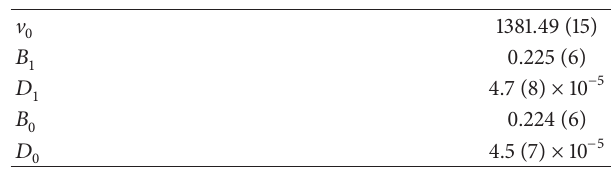
Table 1: Effective molecular constants for the V 7 band of iso- butylene ∗